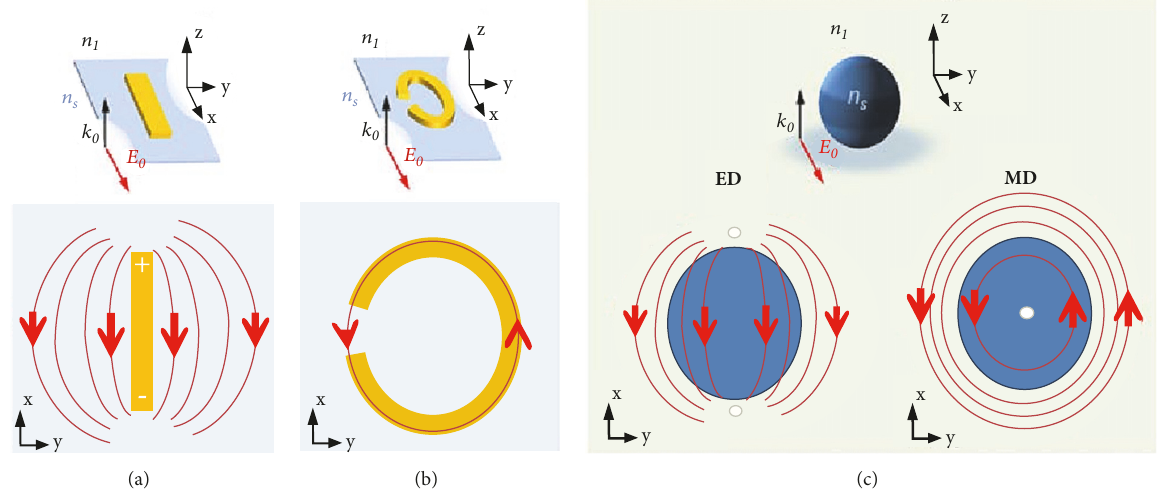
Figure 9: (a, b) Diagram of electric field in plasmonic resonator; (c) diagram of electric field in dielectric sphere. The plasmonic rod antennas only stand by electrical resonances and can ignore magnetic contributions. In plasmonic particles, metal rods are formed into a split ring resonator, which can realize strong magnetic dipole resonance